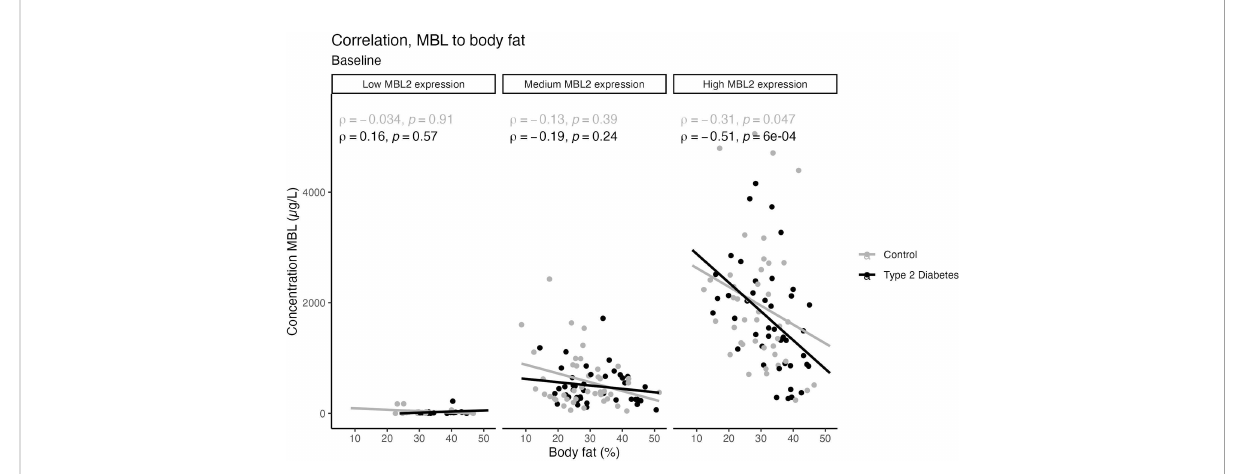
FIGURE 3 Scatter plots with trend lines showing a possible linear relationship between body fat percentage and Serum MBL levels, divided by MBL expressing genotype. Grey dots represent healthy individuals and the black dots represent participants with T2D. Spearman ’ s correlation analysis was used to generate the correlation coef fi cients and associated p-value.